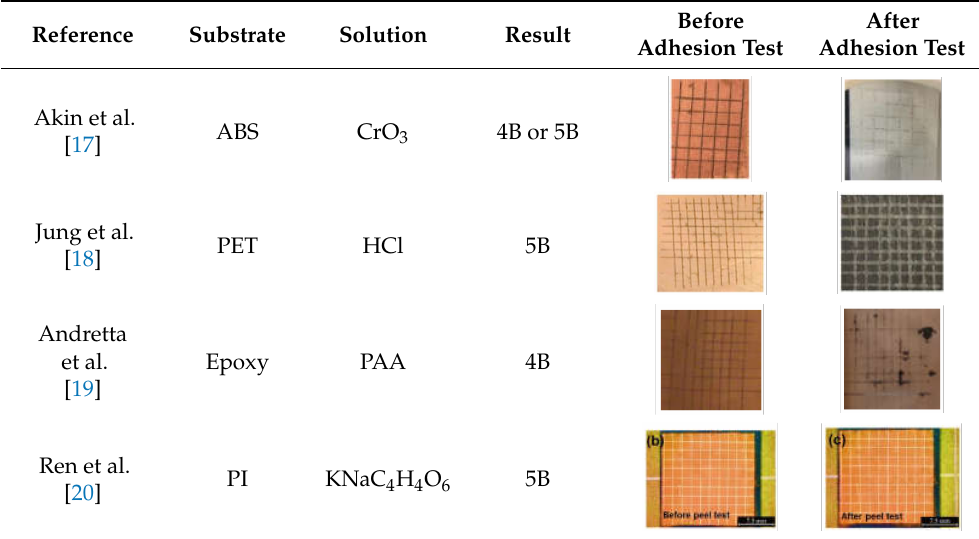
Figure 6. Images of ASTM D3359 adhesive strength results: ( a ) After H 2 SO 4 swelling; ( b ) After KMnO 4 etching. Table 3. Comparisons of reference electroless plating